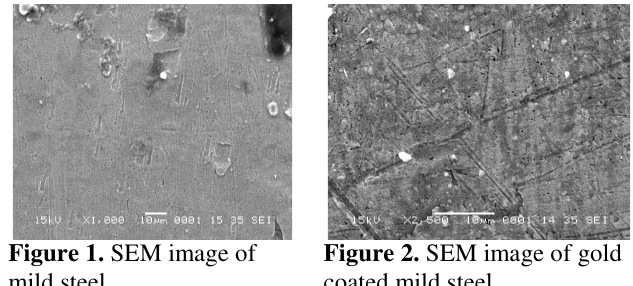
Figure 1. SEM image of mild steel